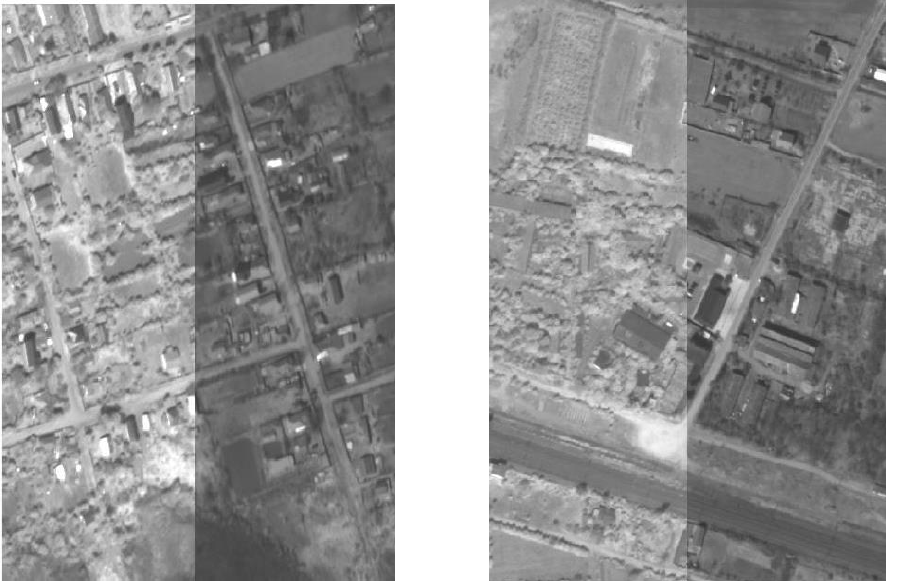
Figure 11. Sample images showing geometric consistency at a boundary.